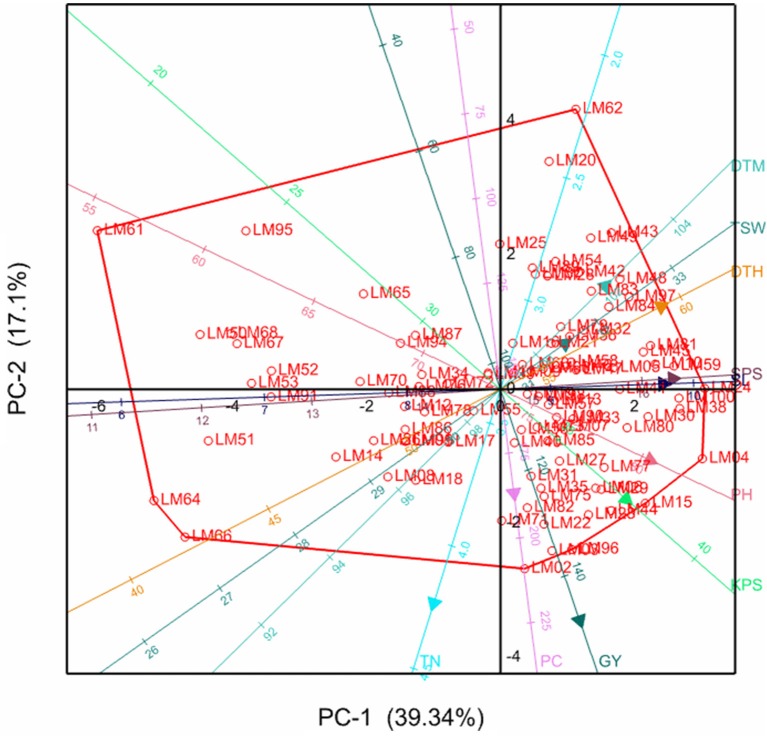
Principal component biplot showing genotypic grouping under stress. DTH, days to 50% heading; DTM, days to maturity; GY, grain yield per plot; SL, spike length; KPS, number of kennels per plant; PC, proline content; PH, plant height; TN, number of productive tillers; SPS, number of spikelets per spike; TSW, thousand seed weight.